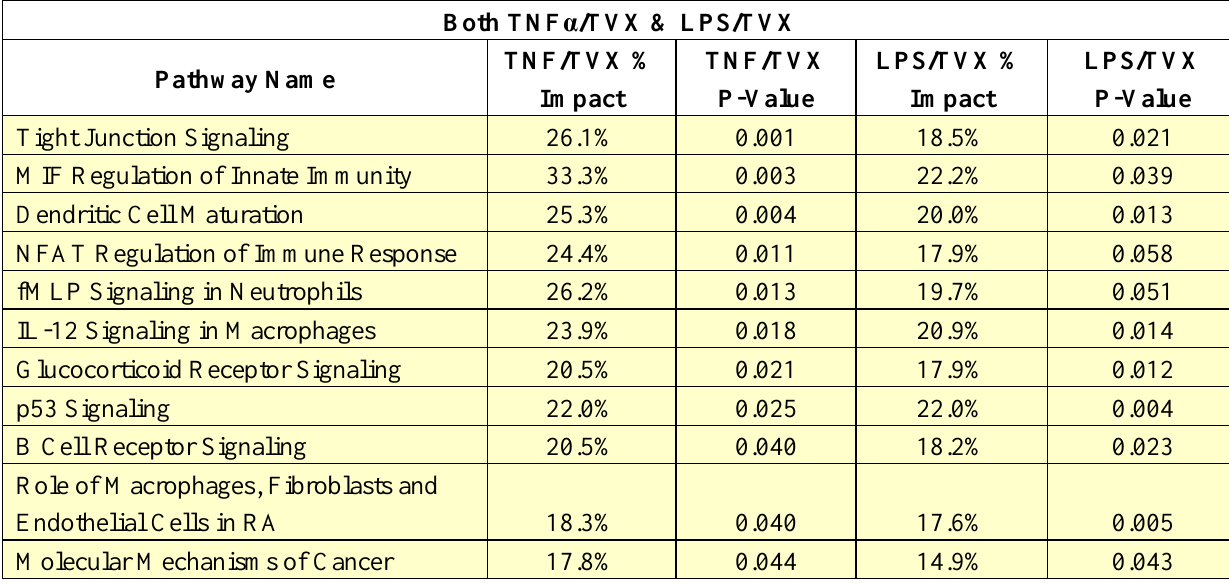
Table 1. List of Biochemical Pathways Regulated in Common Between TNFα/TVX and LPS/TVX.